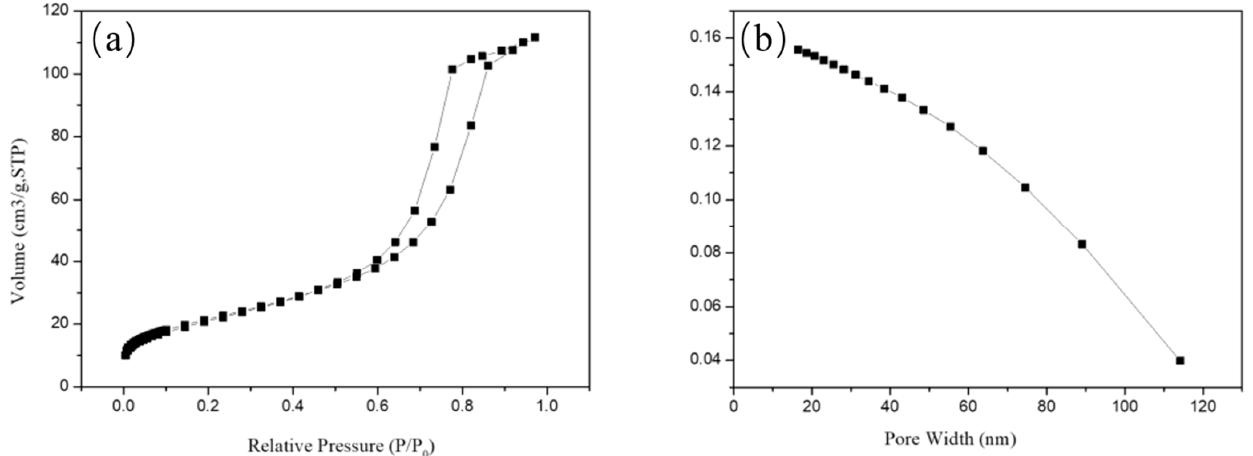
Figure 1. Isotherms of nitrogen adsorption–desorption and pore width of the TiO 2 /CNT/CQD mesoporous composite. ( a ) Nitrogen adsorption–desorption isotherms and pore width of TiO 2 /CNT/CQD, ( b ) aperture distribution map.